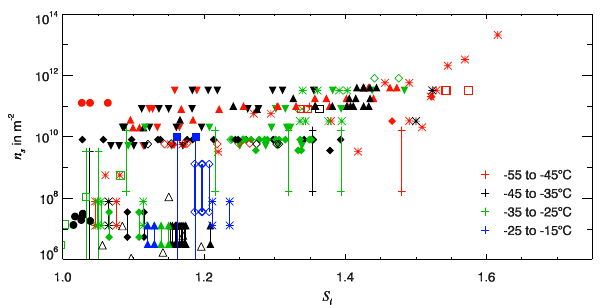
Fig. 15. INAS densities for ATD, kaolinite and desert dusts for de- position nucleation, binned into temperature intervals. The symbols and data sources are the same as in Fig.